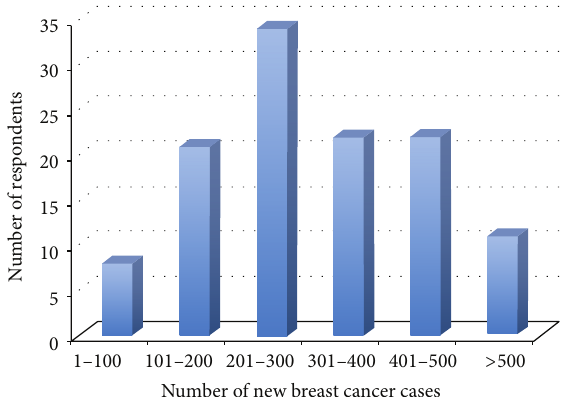
Figure 1: Number of New Breast Cancers seen by Respondents’ Units.